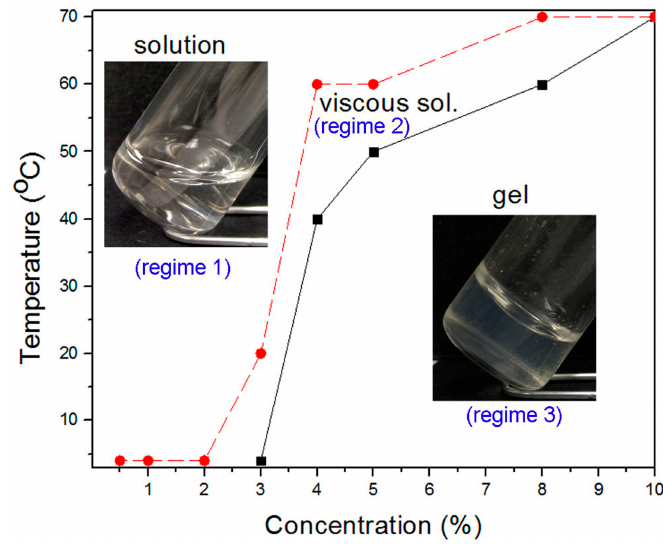
Figure 2. Phase diagram of 1 in water at pH = 7 showing the three regimes: solution, viscous solution, and gel.